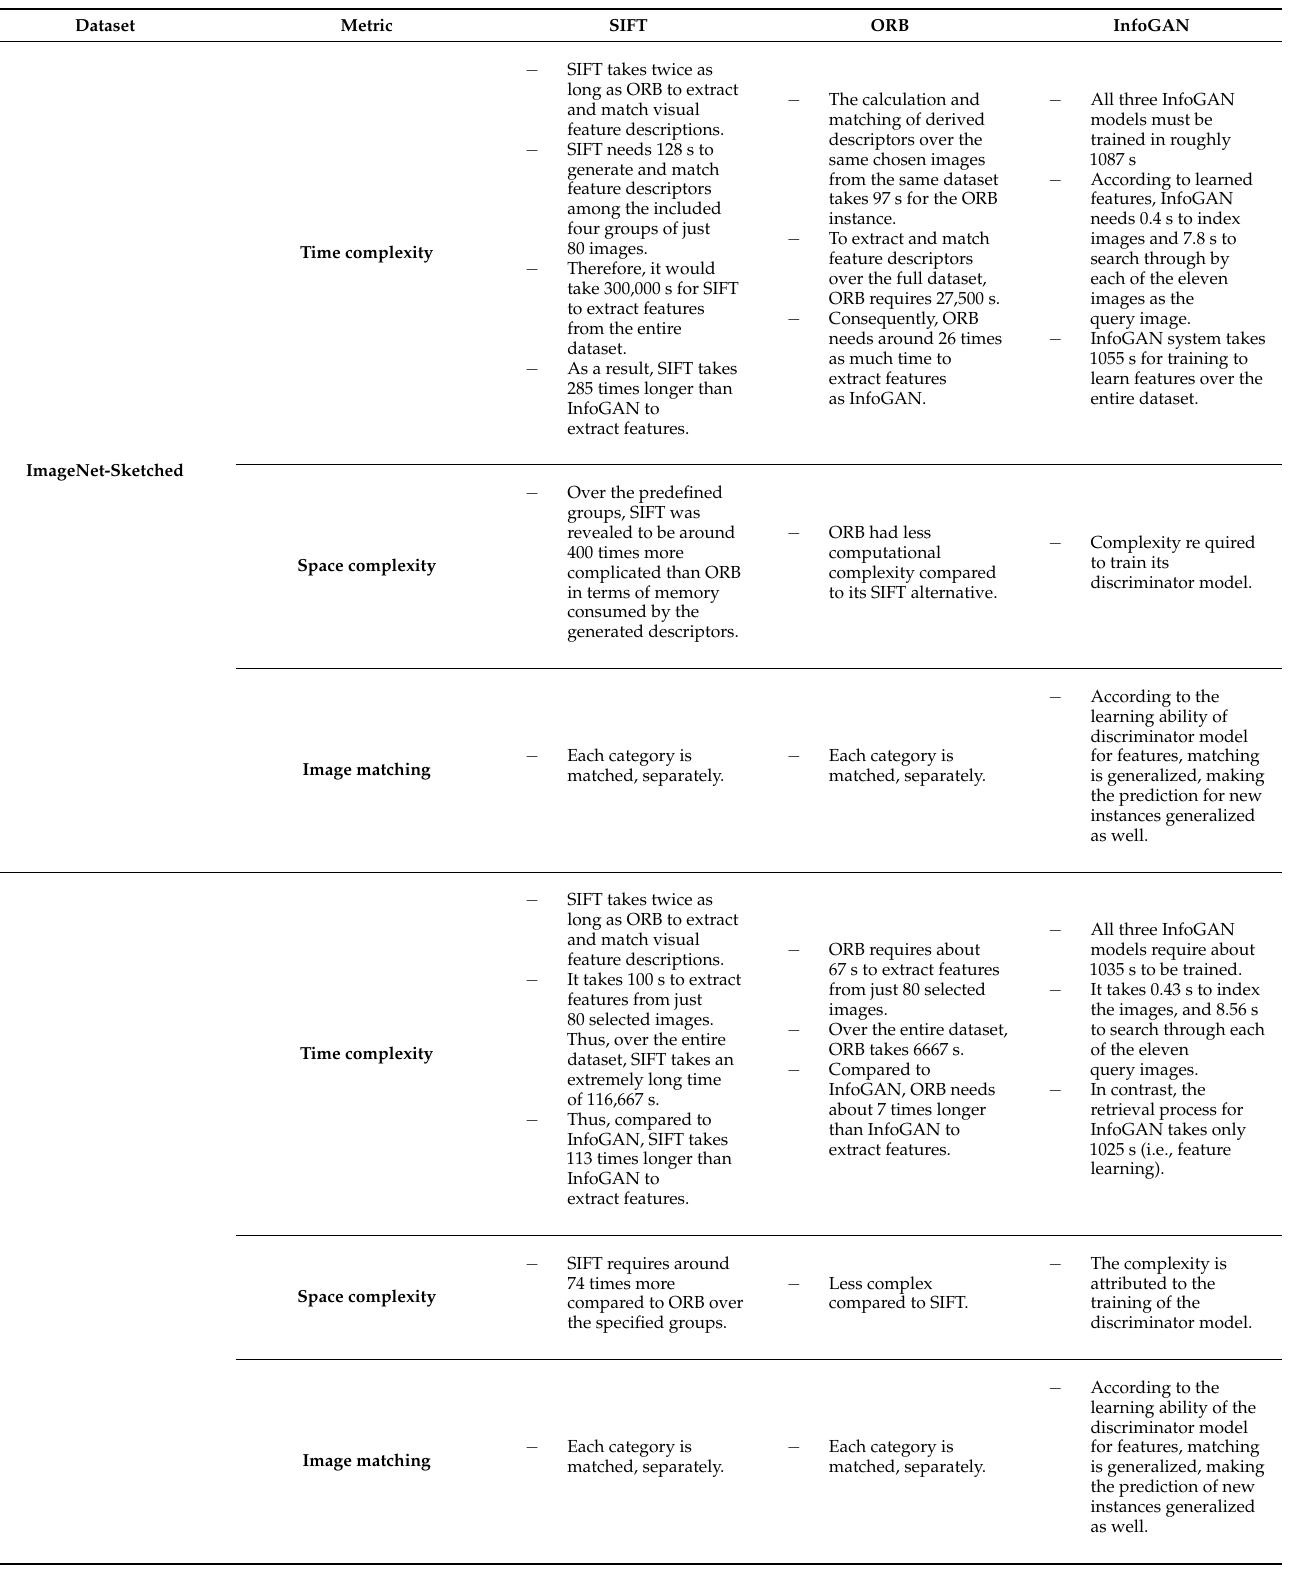
Table 3. Complexity and matching performance comparison between the included